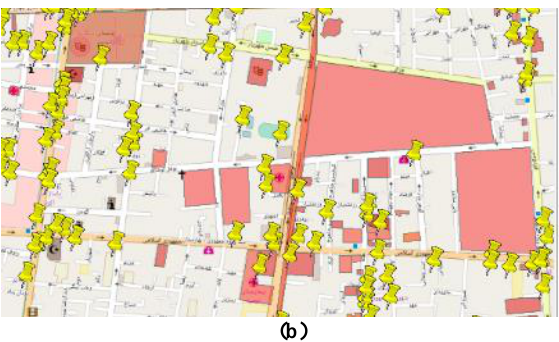
Figure 2. (a) User trajectory; (b) Explored POIs for a restricted region of Tehran